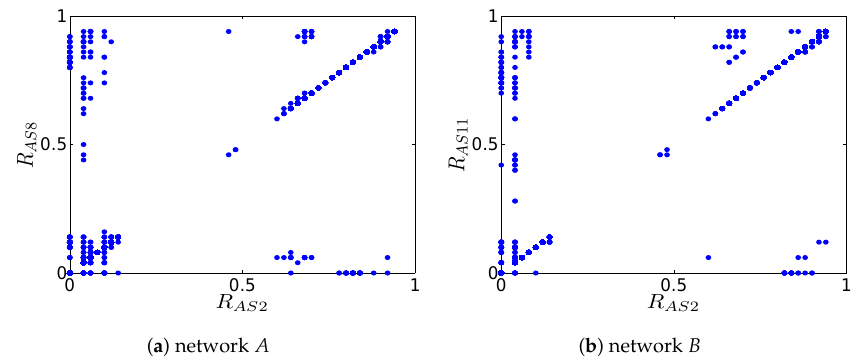
Figure 6. Robustness of interdependent Cyber-Physical network under different attack sequences with same target sets. R AS 8 represents the robustness under attack sequence AS 8, R AS 11 represents the robustness under attack sequence AS 11, and R AS 2 represents the robustness under attack sequence AS